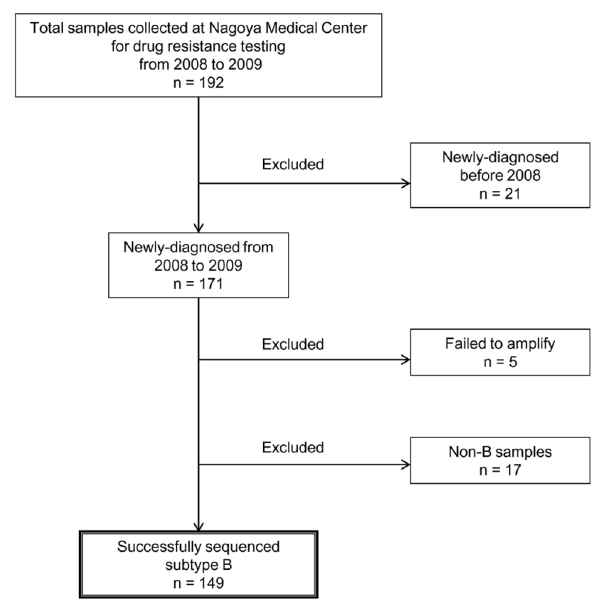
Figure 1. Flow Diagram of sample selection. Flow diagram of sample selection for analysis of minority drug resistance mutations in the HIV-infected patient samples newly diagnosed at National Nagoya Hospital from 2008 to 2009. doi: